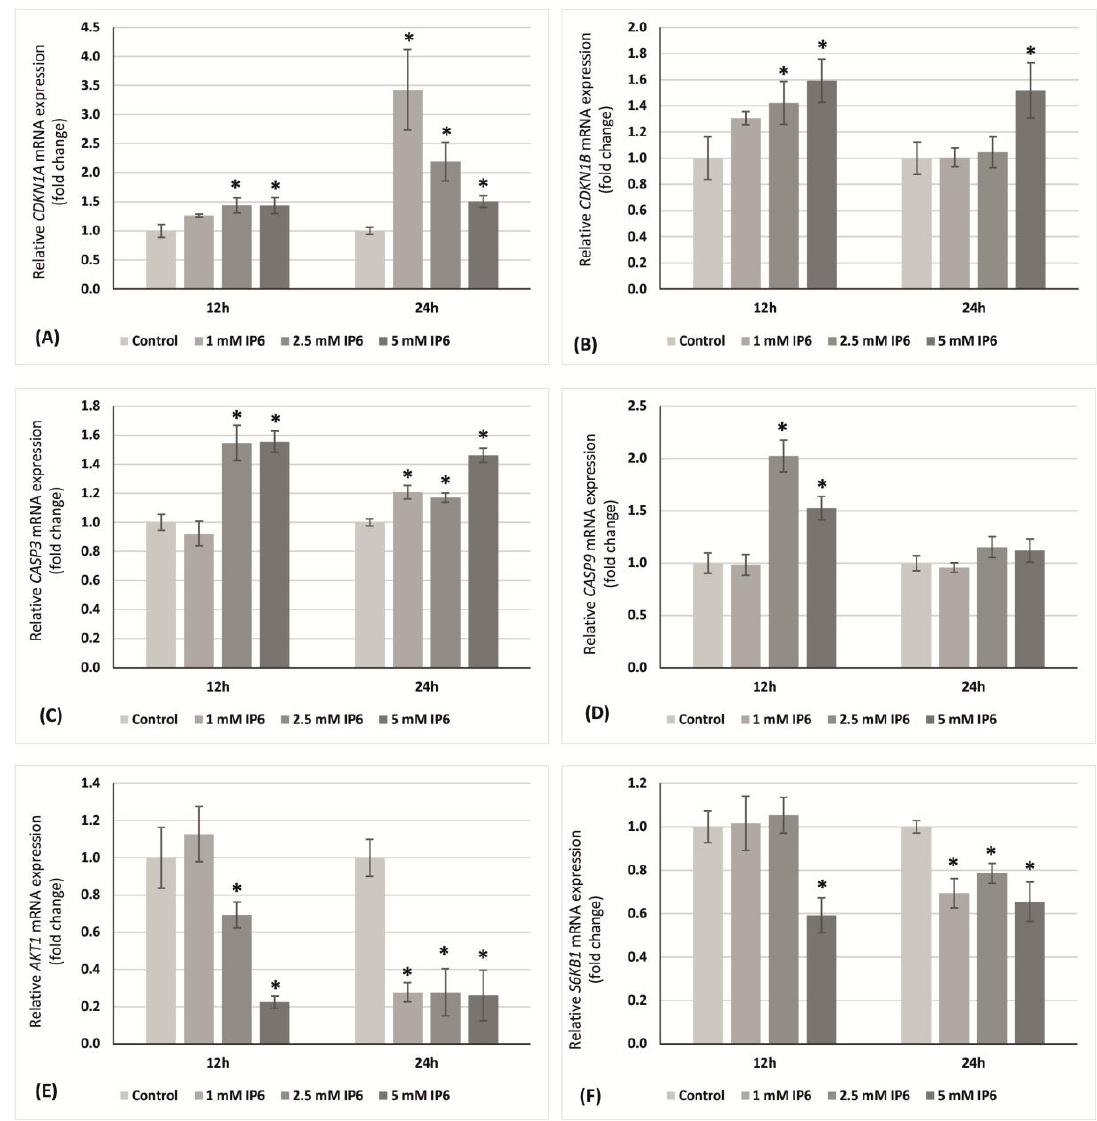
Figure 4. Expression of ( A ) CDNK1A ; ( B ) CDNK1B ; ( C ) CASP3 ; ( D ) CASP9 ; ( E ) AKT1 and ( F ) S6K1 genes in Caco-2 cells as determined by RT-PCR. Changes in mRNAs expression in Caco-2 cells after treatment with 1 mM, 2.5 mM and 5 mM InsP6 for 12 h and 24 h. The results are presented as mean ± SD of three separate experiments; * p < 0.05 vs. control.